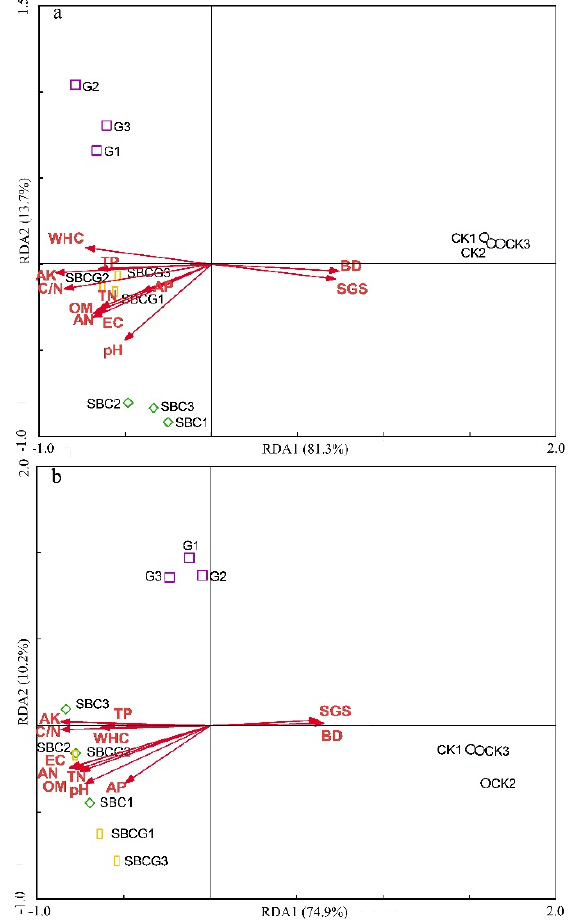
Figure 7. Redundancy analysis (RDA) between soil bacterial communities ( a ) or fungal communities ( b ) and environmental factors in the four different treatments: un ‐ amended control (CK), alfalfa revegetation (G), sludge biochar amendment (SBC), and combined amendment (SBCG) treatments. (G), sludge biochar amendment (SBC), and combined amendment (SBCG)